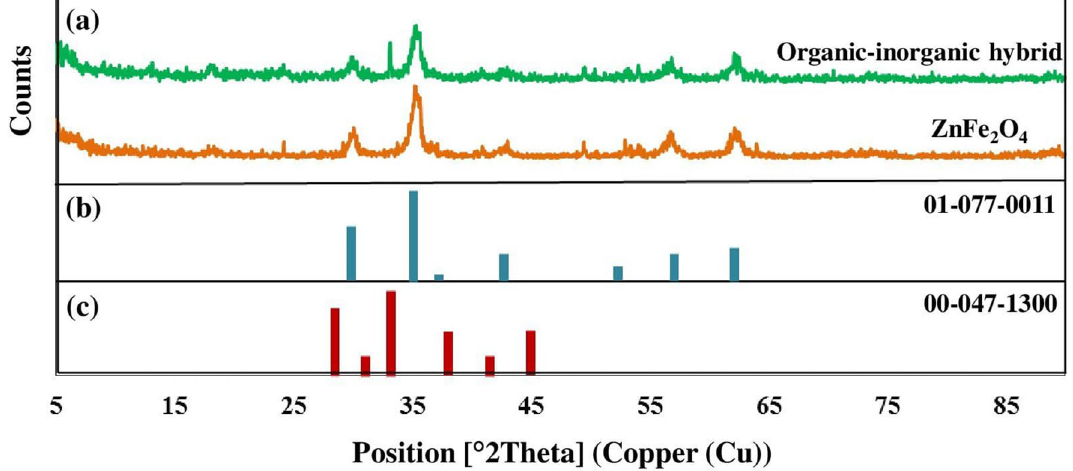
Figure 5. ( a ) XRD Pattern of pure ZnFe 2 O 4 and preparated hybrid by 1,4-phenylenediamine and terephthaloyl chloride on the magnetic